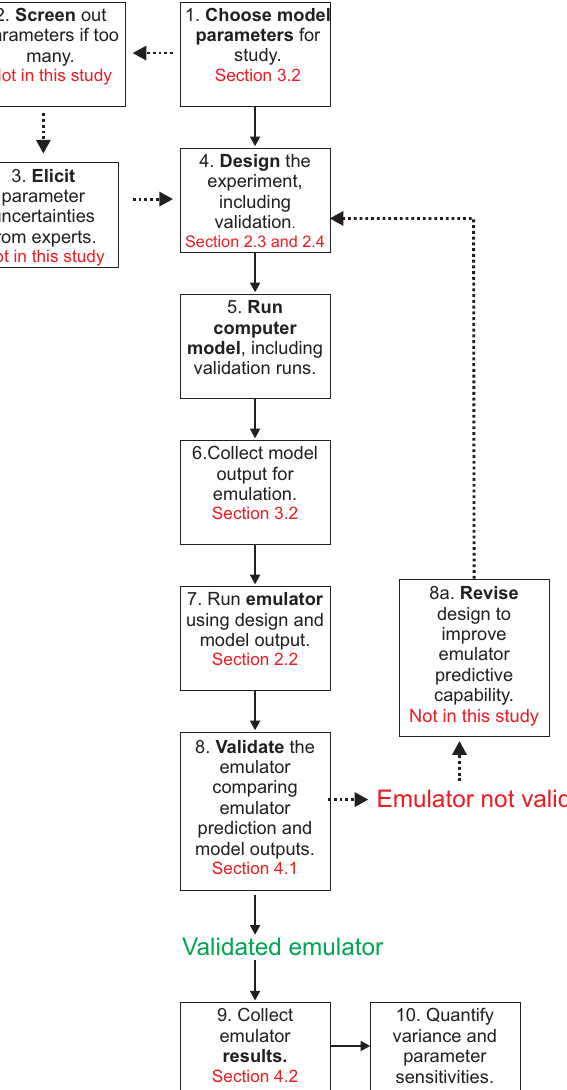
Fig. 1. The basic procedure to follow in an emulation